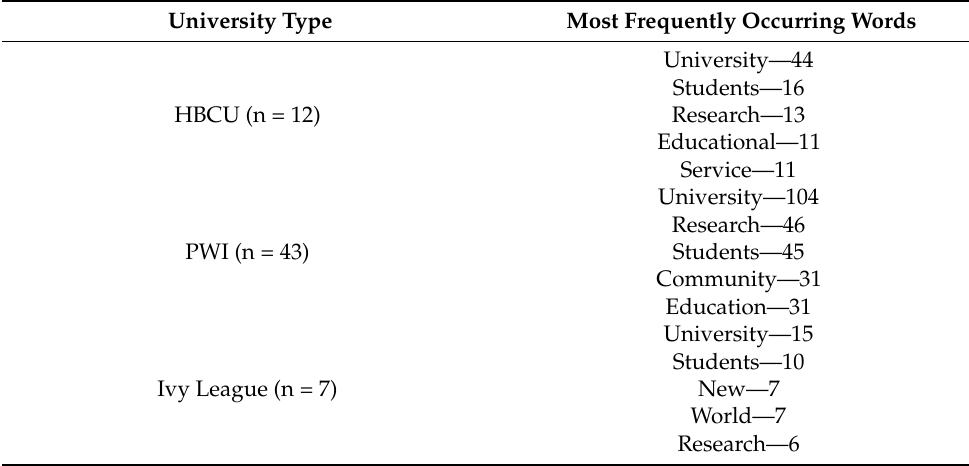
Table 2. Frequency of relevant terms in mission statements by university type.